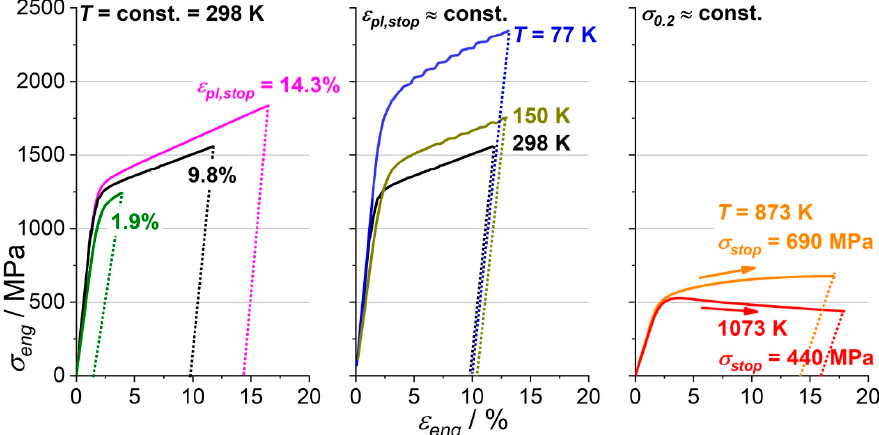
Figure 3. Mechanical properties of as-homogenized HfNbTaTiZr under compression at an initial strain rate of 10 − 3 s − 1 : Stress-strain curves of terminated compression tests at constant test temperature ( left ), comparable plastic strain ε pl , stop ( center ) and comparable yield strength σ 0.2 ( right ). Yield strength σ 0.2 , plastic strain ε pl , stop and stress σ stop at test termination are pointed out in Table 3. Table 3. Test parameters and characteristic values of HfNbTaTiZr determined by terminated